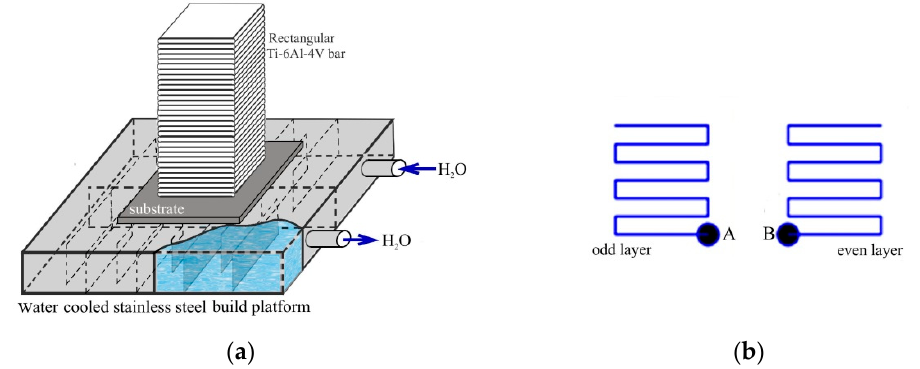
Figure 1. Schematic of an as-built EBAM sample during water-cooled installation ( a ) and electron beam scanning path trajectories in the form of a meander used in the EBAM process ( b ). Table 1. Chemical composition of grade 5 titanium